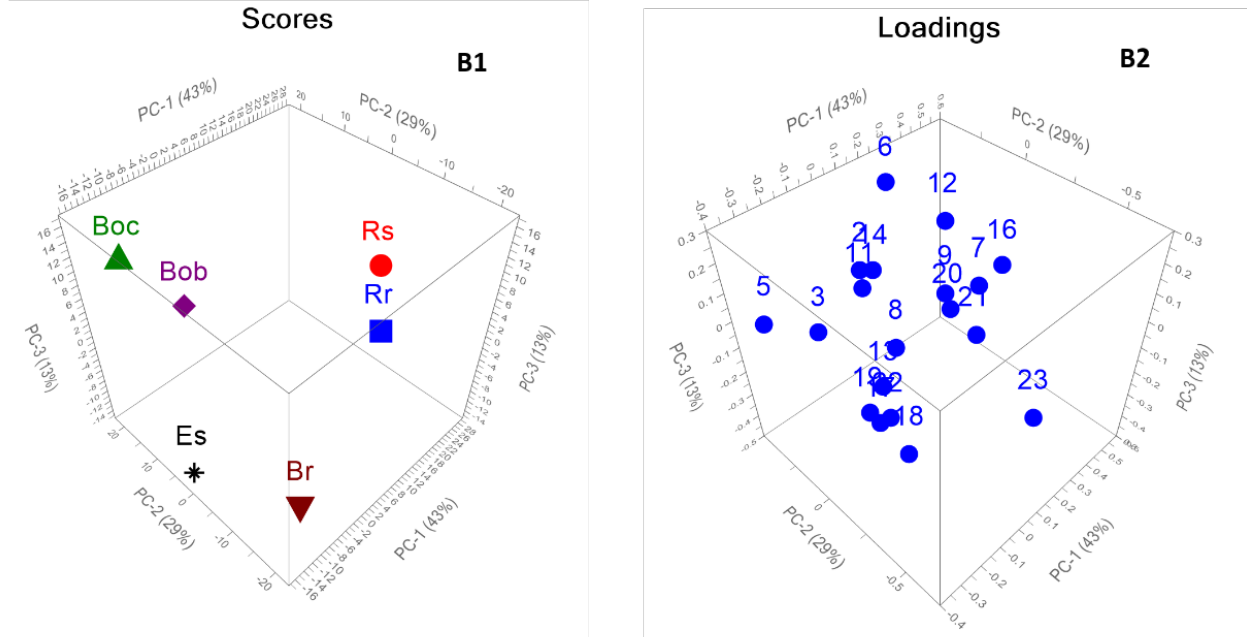
Figure 4. 3D PCA score ( A1 ) and loading ( A2 ) plots based on volatile compounds chemical profiling identified by GC-MS of six Brassicaceae seeds. 3D PCA score ( B1 ) and loading ( B2 ) plots based on glucosinolates chemical profiling identified by HPLC of six Brassicaceae seeds.